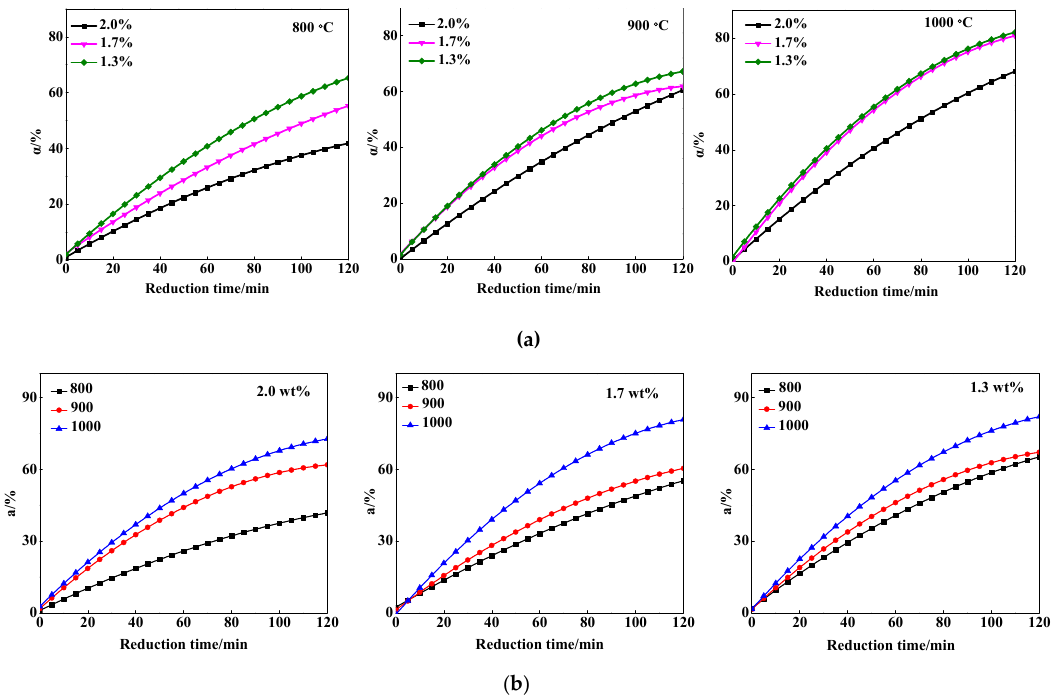
Figure 4. Reduction degree with different raw materials and temperatures: ( a ) reduction temperatures; ( b ) MgO content sinters.